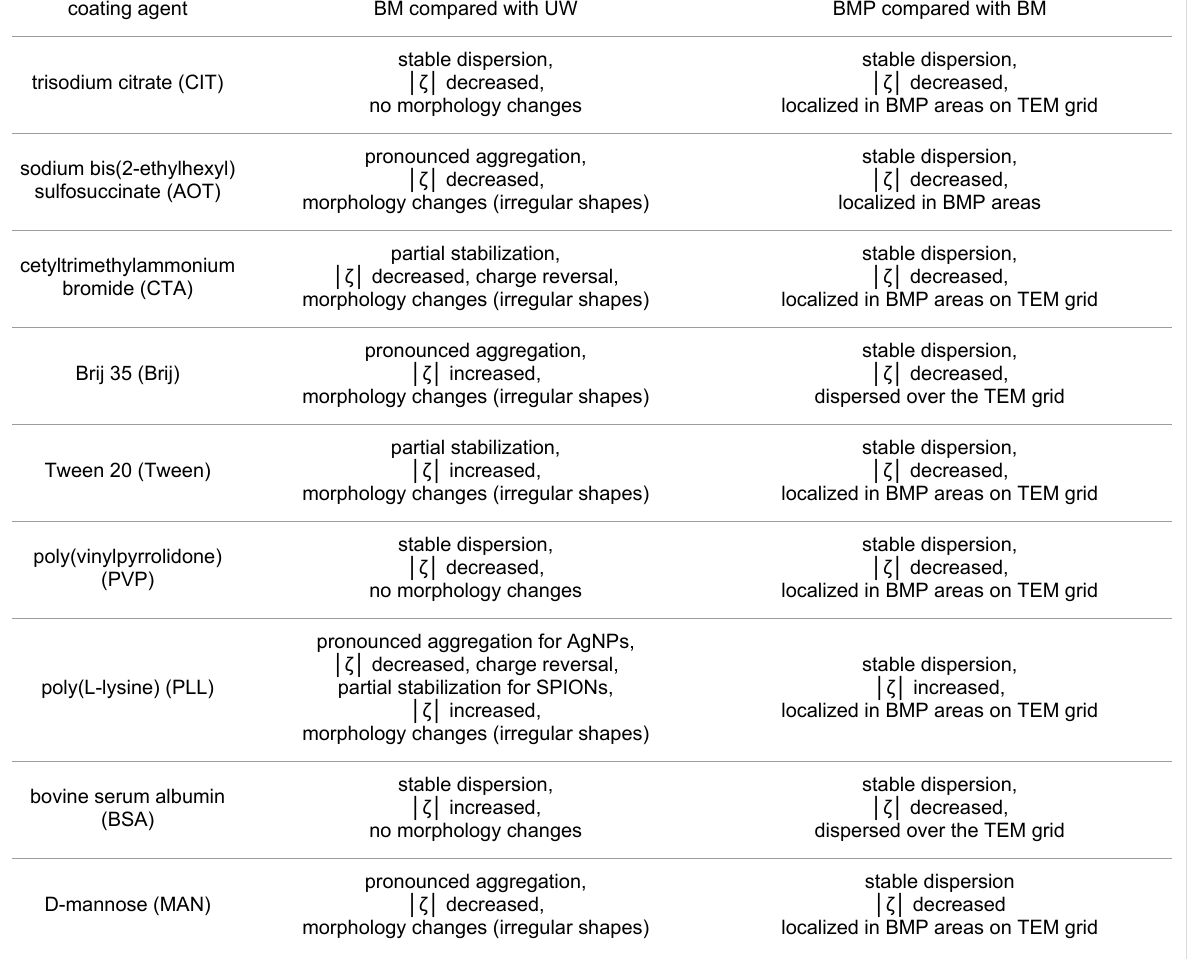
Table 4: Summarized effects of different coating agents on the stability of silver and maghemite nanoparticles in model biological medium after 1 h. UW - ultrapure water, BM - biological cell culture medium without addition of protein, BMP - BM supplemented with common serum protein. coating agent BM compared with UW BMP compared with